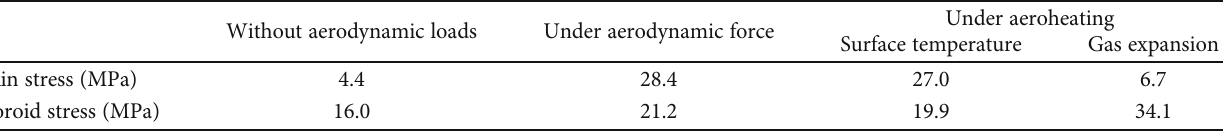
Table 3: Comparison of aerodynamic e ff ects on stress.